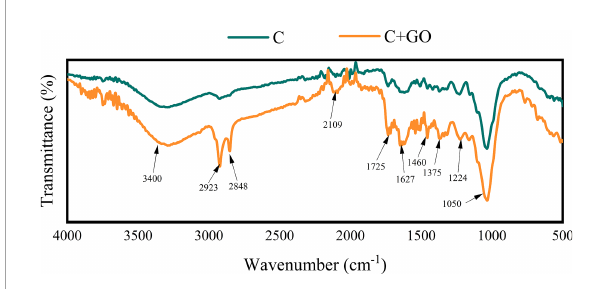
FIGURE 10 Characteristics of the stem incisions from the C and C+GO groups examined by Fourier transform infrared